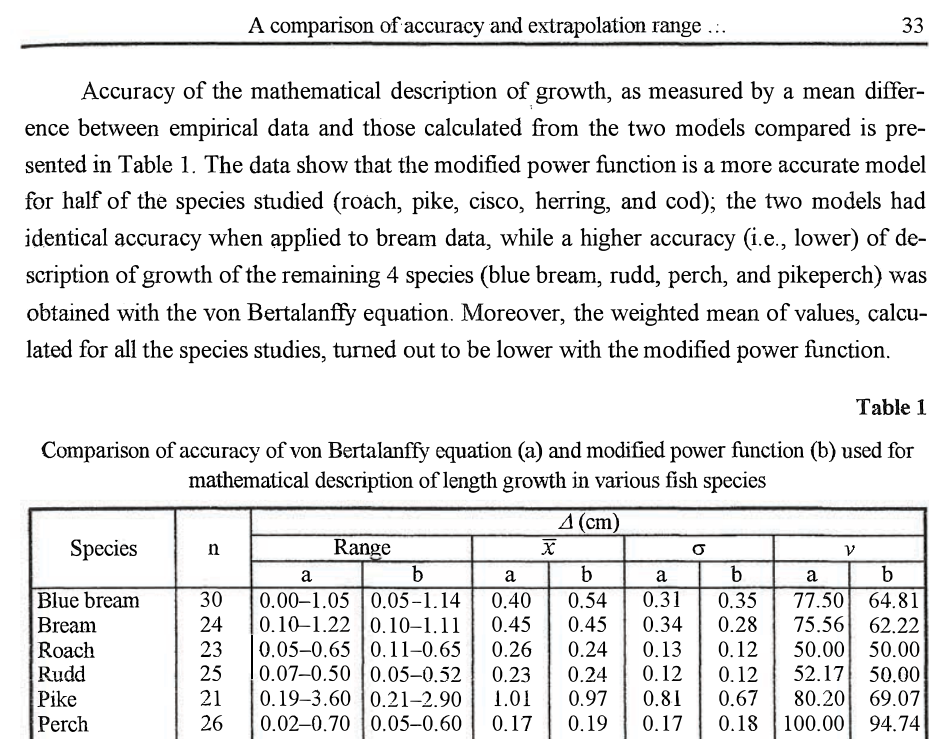
Comparison of accuracy ofvon Bertalanffy equation (a) and modified power function (b) used for mathematical description of length growth in various fish species A (cm) Species